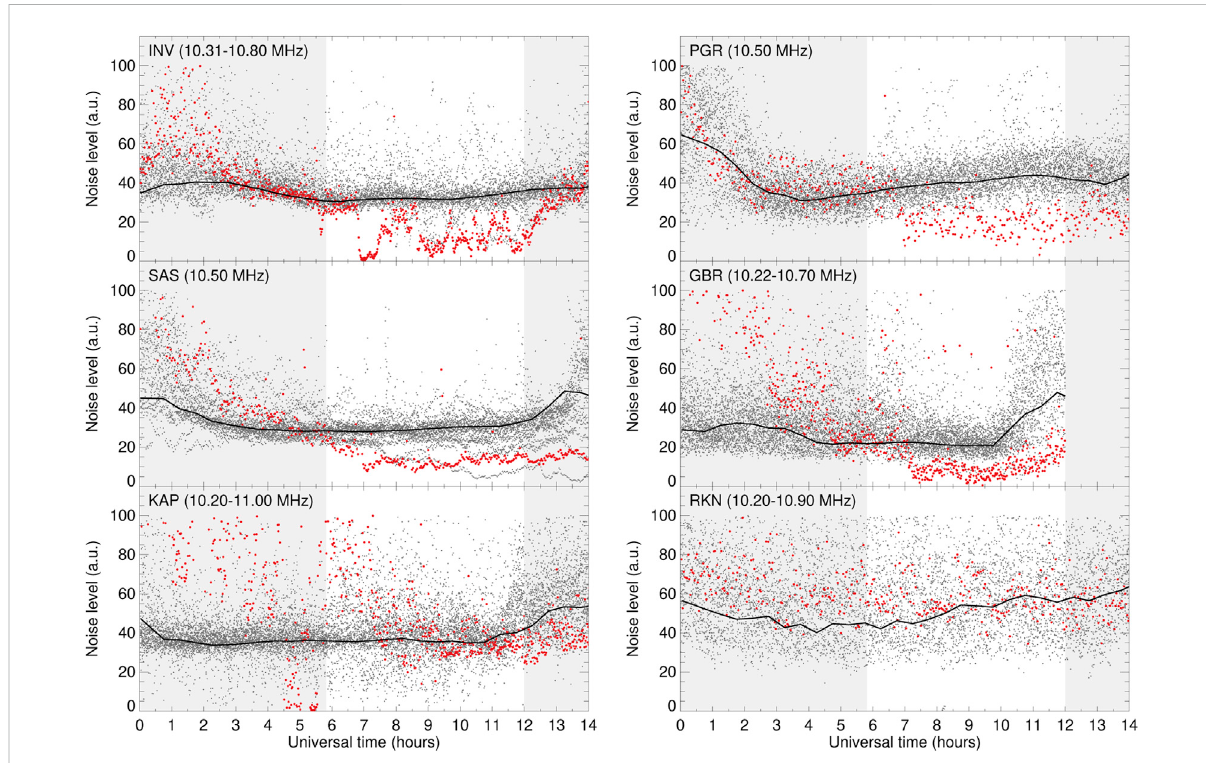
FIGURE 4 HF radio noise measurements from six SuperDARN radars in North America. The grey dots show noise measurements for the 21-day period 15 October to 4 November 2019, and the solid black line shows the quiet day curve derived from these data. The red dots show the noise measurements for the event day (25 October 2019). Grey shading indicates time periods before and after the substorm